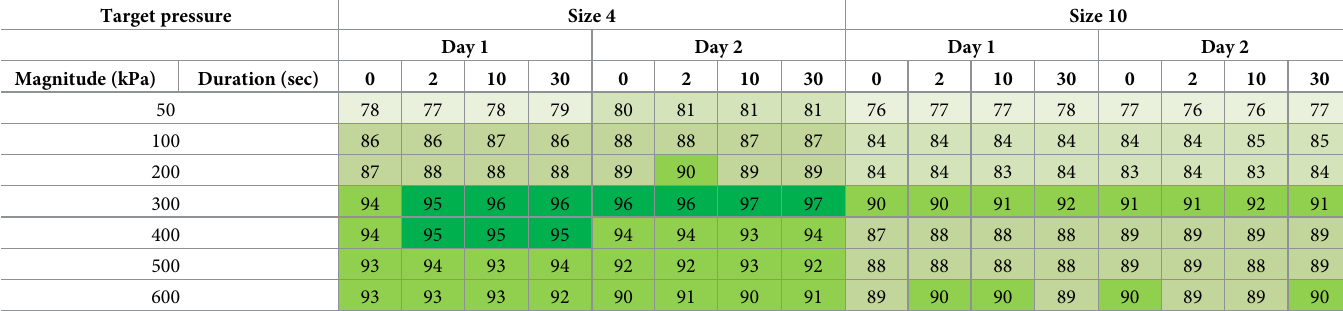
Table 3. Percentage of sensels within 5% of mean value for all pressures and times and each insole size and day 1 and 2. Target pressure Size 4